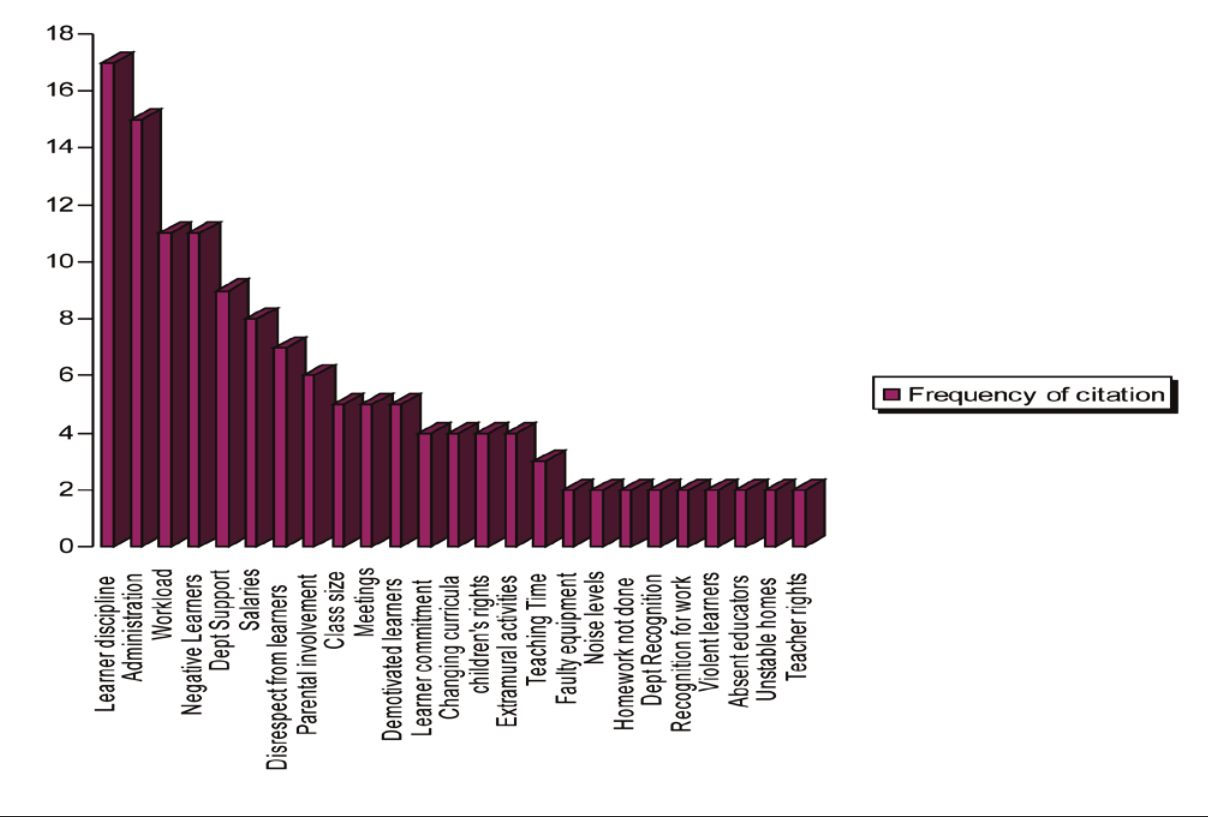
FIGURE 2 Text analysis: Frequency of reported work